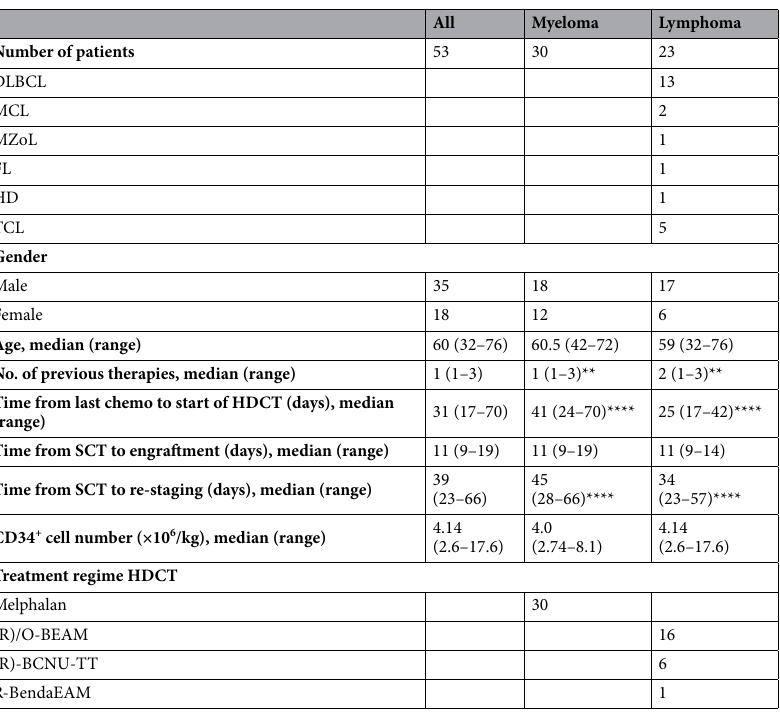
Table 1. Characteristics of HDCT/ auto-SCT patients. DLBCL, diffuse large B-cell lymphoma; MCL, mantle cell lymphoma; MZol, marginal zone lymphoma; FL, follicular lymphoma; HD, Hodgkin disease; TCL, T-cell lymphoma; HDCT, high-dose chemotherapy, R-/O-BEAM, rituximab/ obinutuzumab, carmustine, etoposide, cytarabine, melphalan; R-BCNU-TT: rituximab, carmustine, thiothepa; R-BendaEAM, rituximab, bendamustin, etoposide, cytarabine, melphalan. Statistical significance was determined using a Mann– Whitney test for unpaired, non-parametric variables and a Chi-square test for categorical variables. P values comparing myeloma and lymphoma patients **P < .01, ****P <